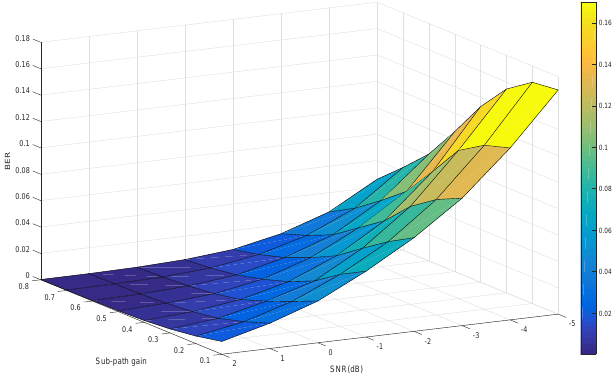
Figure 12. BER for symbol joint decision as a function of SNR and sub-path